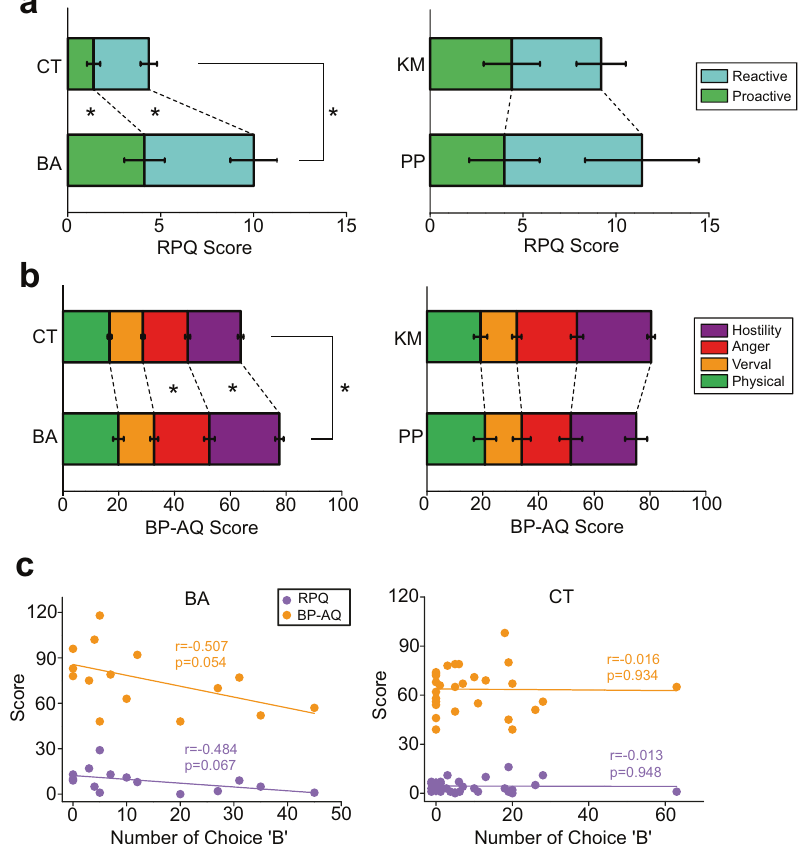
Fig. 5 Questionnaire surveys for assessments of aggression. a Bar graphs showing comparisons of proactive vs. reactive aggression with the Reactive-Proactive Aggression Questionnaire (RPQ) between behavioural addiction (BA) patients and control (CT) subjects (left) and between kleptomania (KM) and paraphilia (PP) patients (right). b Graphs similar to (a) but showing assessments of aggression with the Buss – Perry Aggression Questionnaire (BP-AQ), in which scores for physical aggression, verbal aggression, anger, and hostility dimensions of aggression were stacked. ( c ) Graphs showing correlations between the number of choices re fl ecting aggression (B button) and the RPQ and BP-AQ scores in BA patients (left) and CT subjects